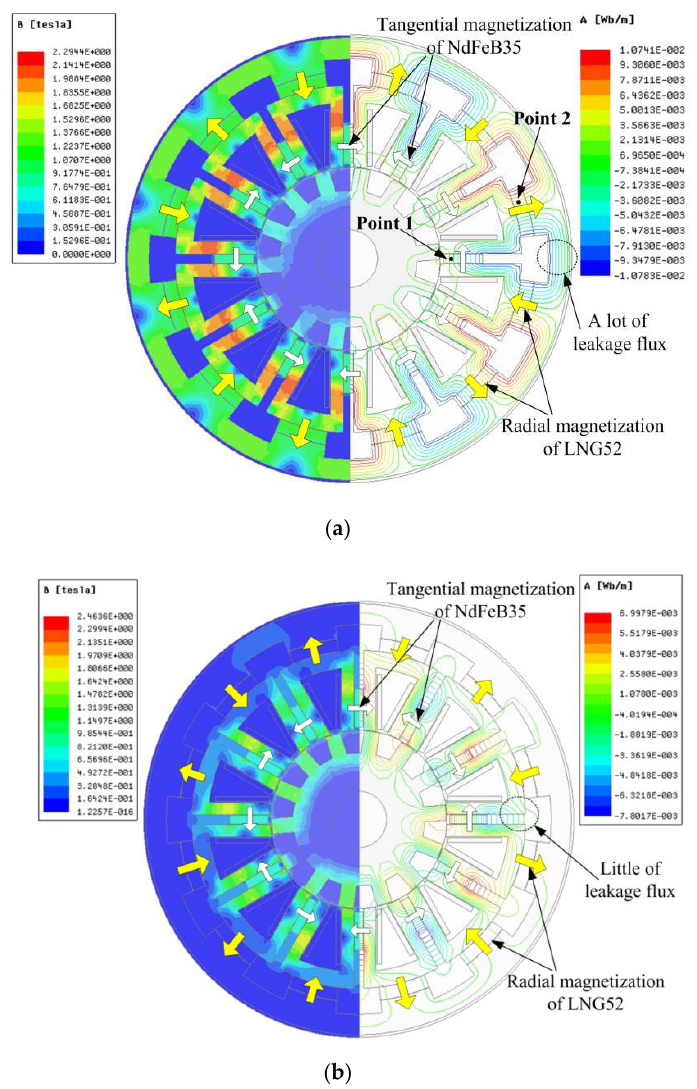
Figure 7. Simulation models of weaken flux and enhance flux. ( a ) Weaken flux model of VFMPM machine (magnetization of LNG52); ( b ) Enhance flux model of VFMPM machine (demagnetization of LNG52).